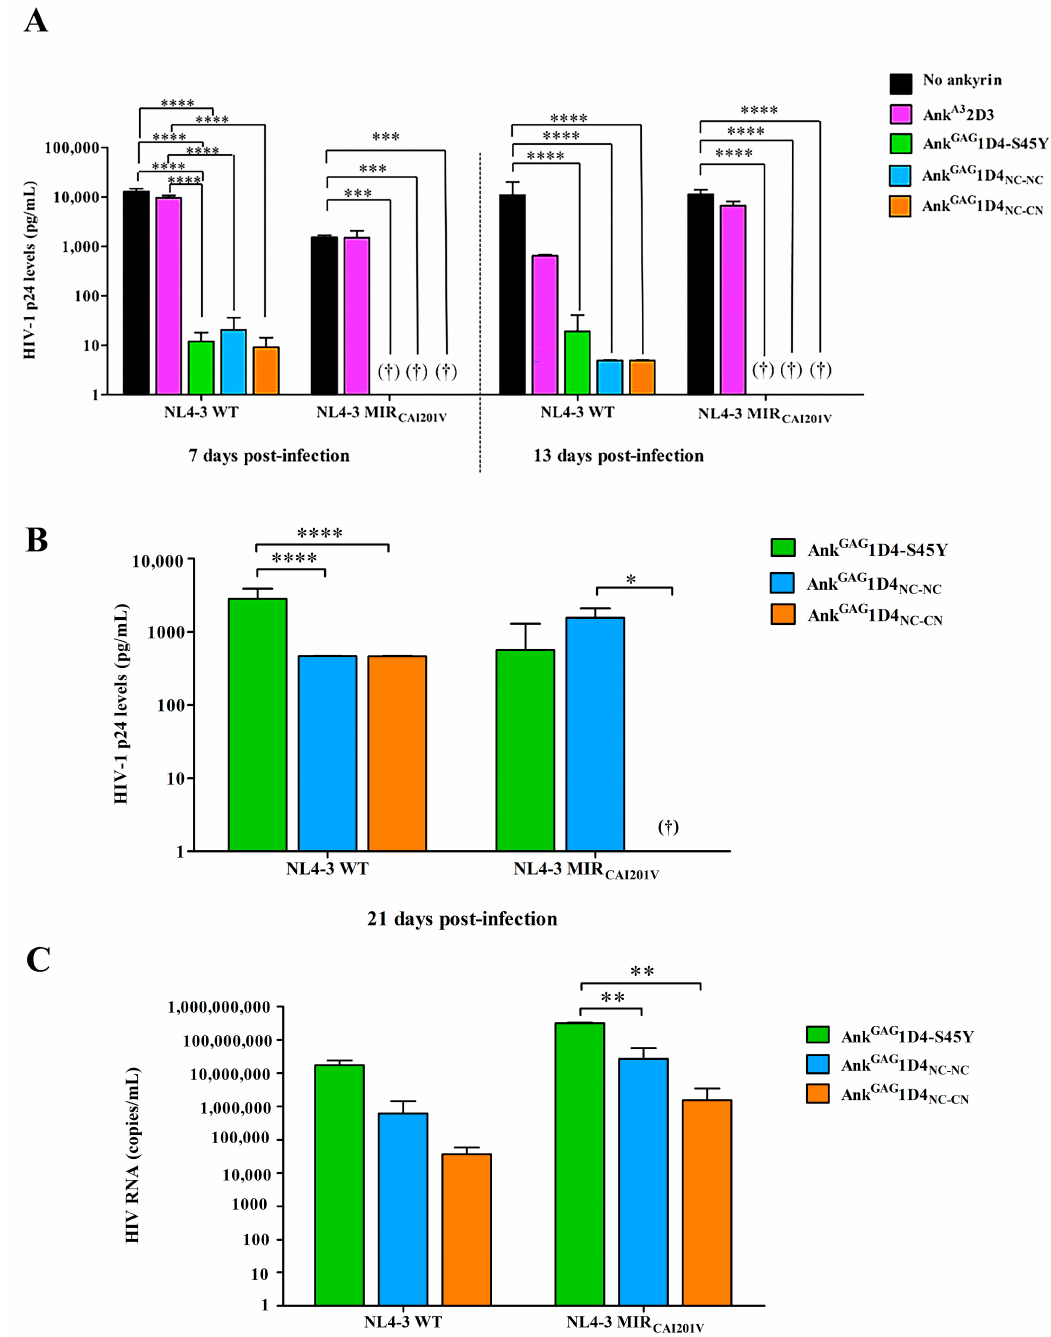
Figure 9. HIV-1 production in infected SupT1 and ankyrin-expressing SupT1 cells. Culture super- natant of HIV-1 WT or HIV-1 NL4-3 MIR CAI201V infected cells was collected at ( A ) 7, 13, and ( B ) 21